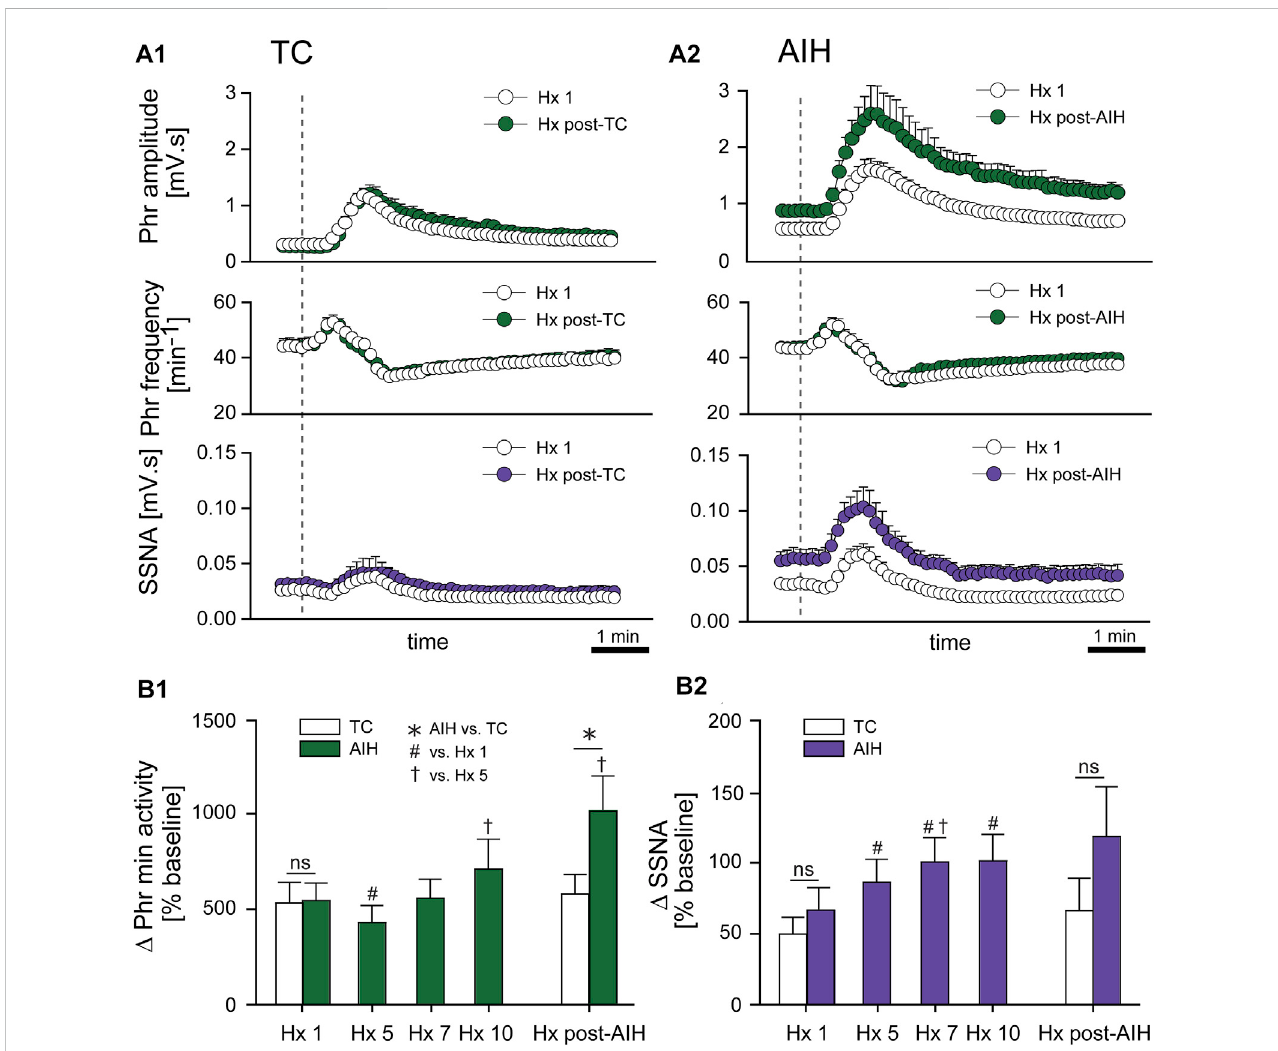
FIGURE 4 AIH increases PhrNA and SSNA responses to hypoxia. (A) Mean response to an initial bout of hypoxia (10% O 2 , 45 sec; Hx 1, white circles) and hypoxia following time control (A1) , Hx post-TC, green (PhrNA) or purple (SSNA) circles, n = 6) or after exposure to AIH (A2) , Hx post-AIH, green (PhrNA) or purple (SSNA)circles,n=11).Verticallinemarkstheonsetoftheanimalbreathing10%O 2 .NeitherbaselinePhrNAandSSNAnortheresponsetoHx(Hx1vs.Hxpost- TC) was altered in TC (A1) . 1 h after AIH, baseline Phr amplitude and SSNA were elevated and the post-AIH Hx responses were augmented (Interaction: Phr amplitude, p = 0.001; SSNA, p = 0.003, Two-way repeated measures ANOVA) whereas Phr frequencyresponses werevery similar (A2) . (B) Mean peak Phr minactivity (B1) andSSNA (B2) inresponsetoagivenhypoxicepisode.InitialHx(Hx1)responseswerenotdifferentbetweengroups(Phrminactivity: p =0.93, SSNA: p = 0.48, t -test). TC did not alter the response to hypoxia (Hx 1 vs. Hx post-TC: Phr min activity: p = 0.74, SSNA p = 0.53, paired t -test). The PhrNA and SSNA responses tohypoxia increased laterduring exposure to AIH(One-wayrepeatedmeasures ANOVA: p ≤ 0.05; #relativetoHx 1, † relativeto Hx5).PhrNA during Hx post-AIH was also signi fi cantly greater compared to Hx post-TC ( p ≤ 0.05, * AIH vs. TC, t -test).